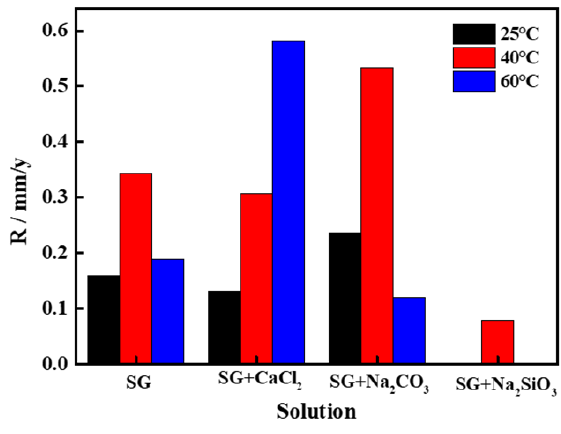
Figure 7. Weight loss corrosion rates of iron after immersion tests in different simulated groundwaters.